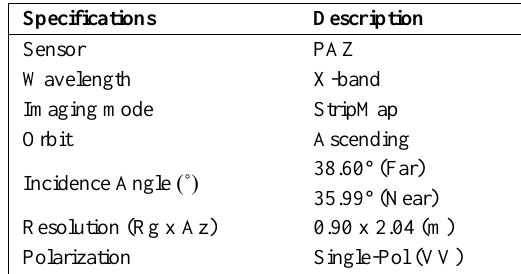
Figure 1 . The study area